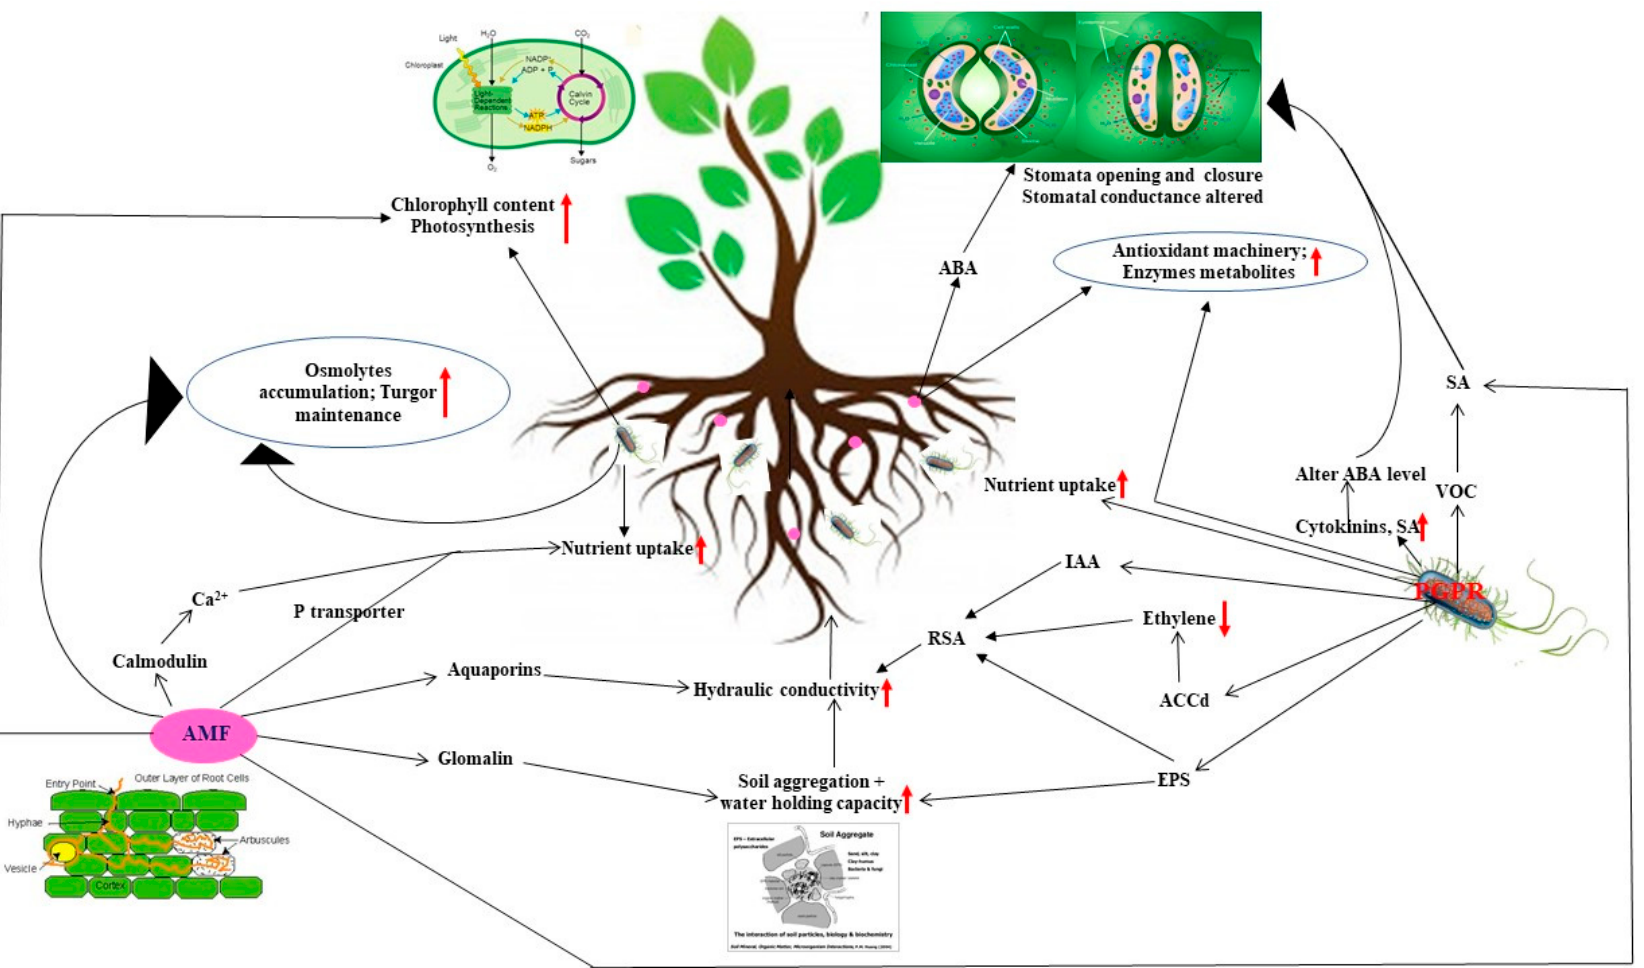
Figure 2. Schematic representation displaying modulation of various plant biochemical and physiological processes in host plants as microbes (AMF and PGPR) buddy up with plants to alleviate drought stress.